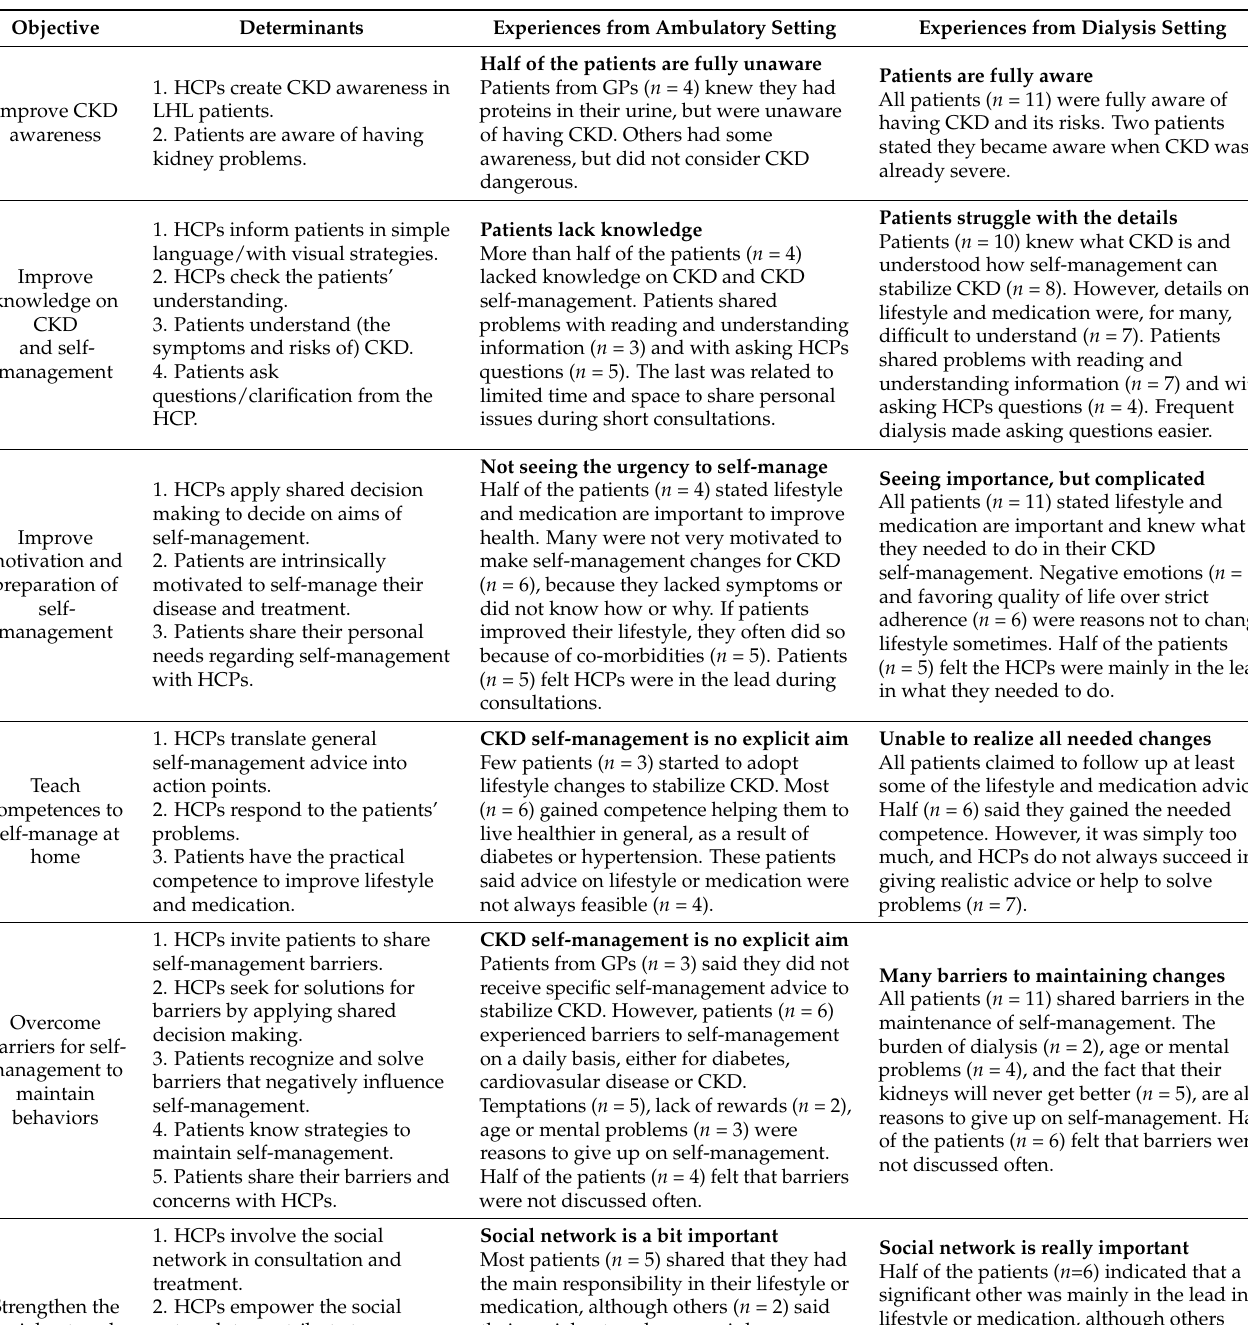
Table 2. Preliminary objectives and determinants aiming to optimize the self-management of CKD patients with LHL, and experiences of ambulatory and dialysis treatments according to the in-depth interviews with patients ( n = 19).